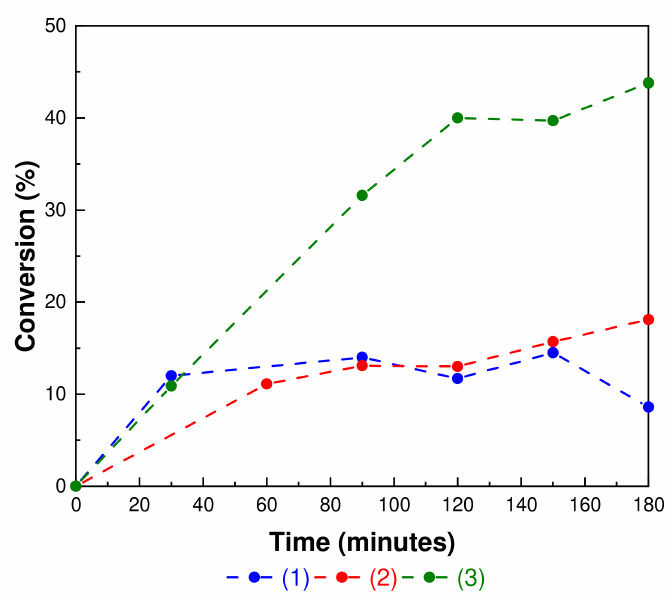
Figure 5. Glycerol conversion as a function of reaction time and catalyst. ( 1 ) Cu NPs/ZrO 2 pH = 4, ( 2 ) Cu NPs/ZrO 2 pH = 7, ( 3 ) Cu NPs/ZrO 2 pH =